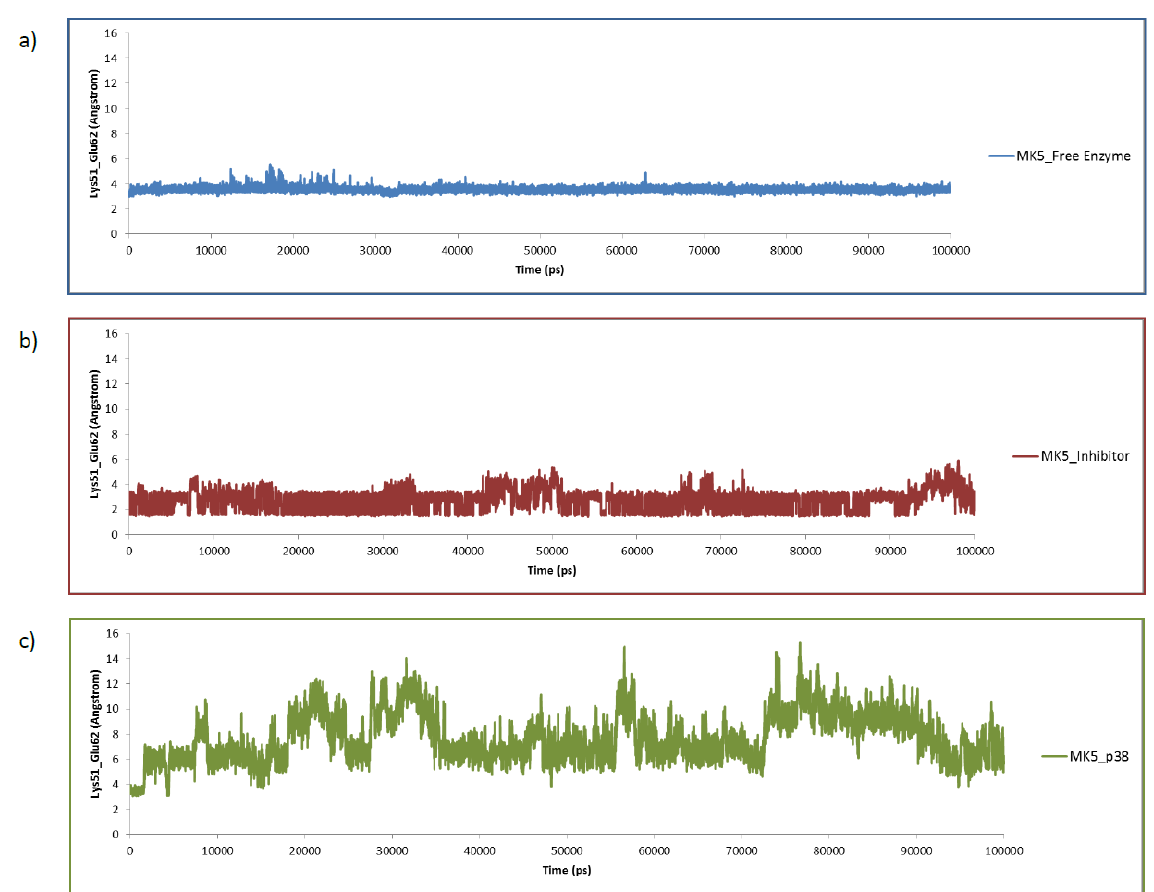
Figure 7. The atomic distances (Å) between Lys51 and Glu62 during 100 ns MD simulations. ( a ) free MK5; ( b ) inhibitor-MK5 complex; ( c ) p38 α -MK5